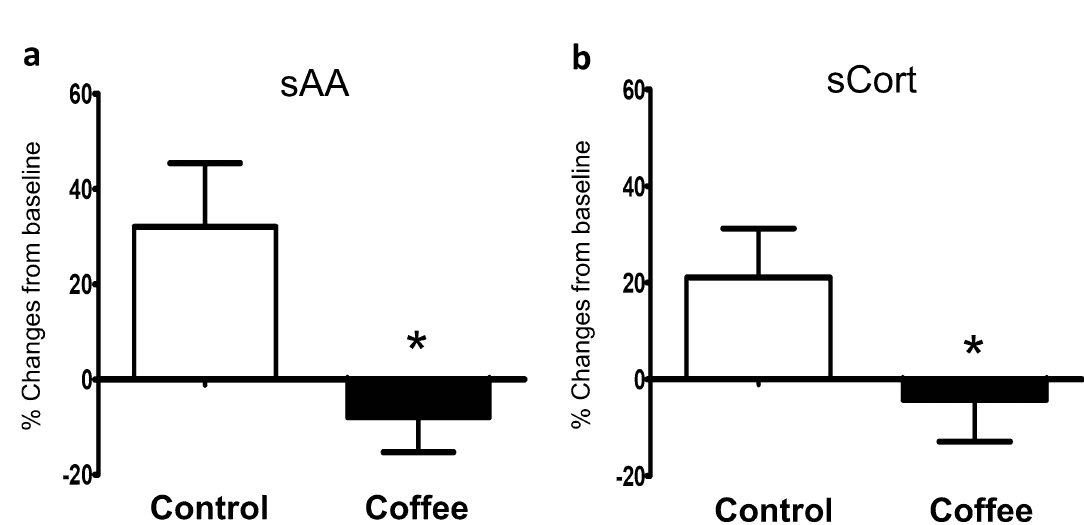
Figure 1. The relative differences (%) from baseline of ( a ) salivary α-amylase (sAA) and ( b ) salivary cortisol (sCort) in control and coffee inhaling groups. p <